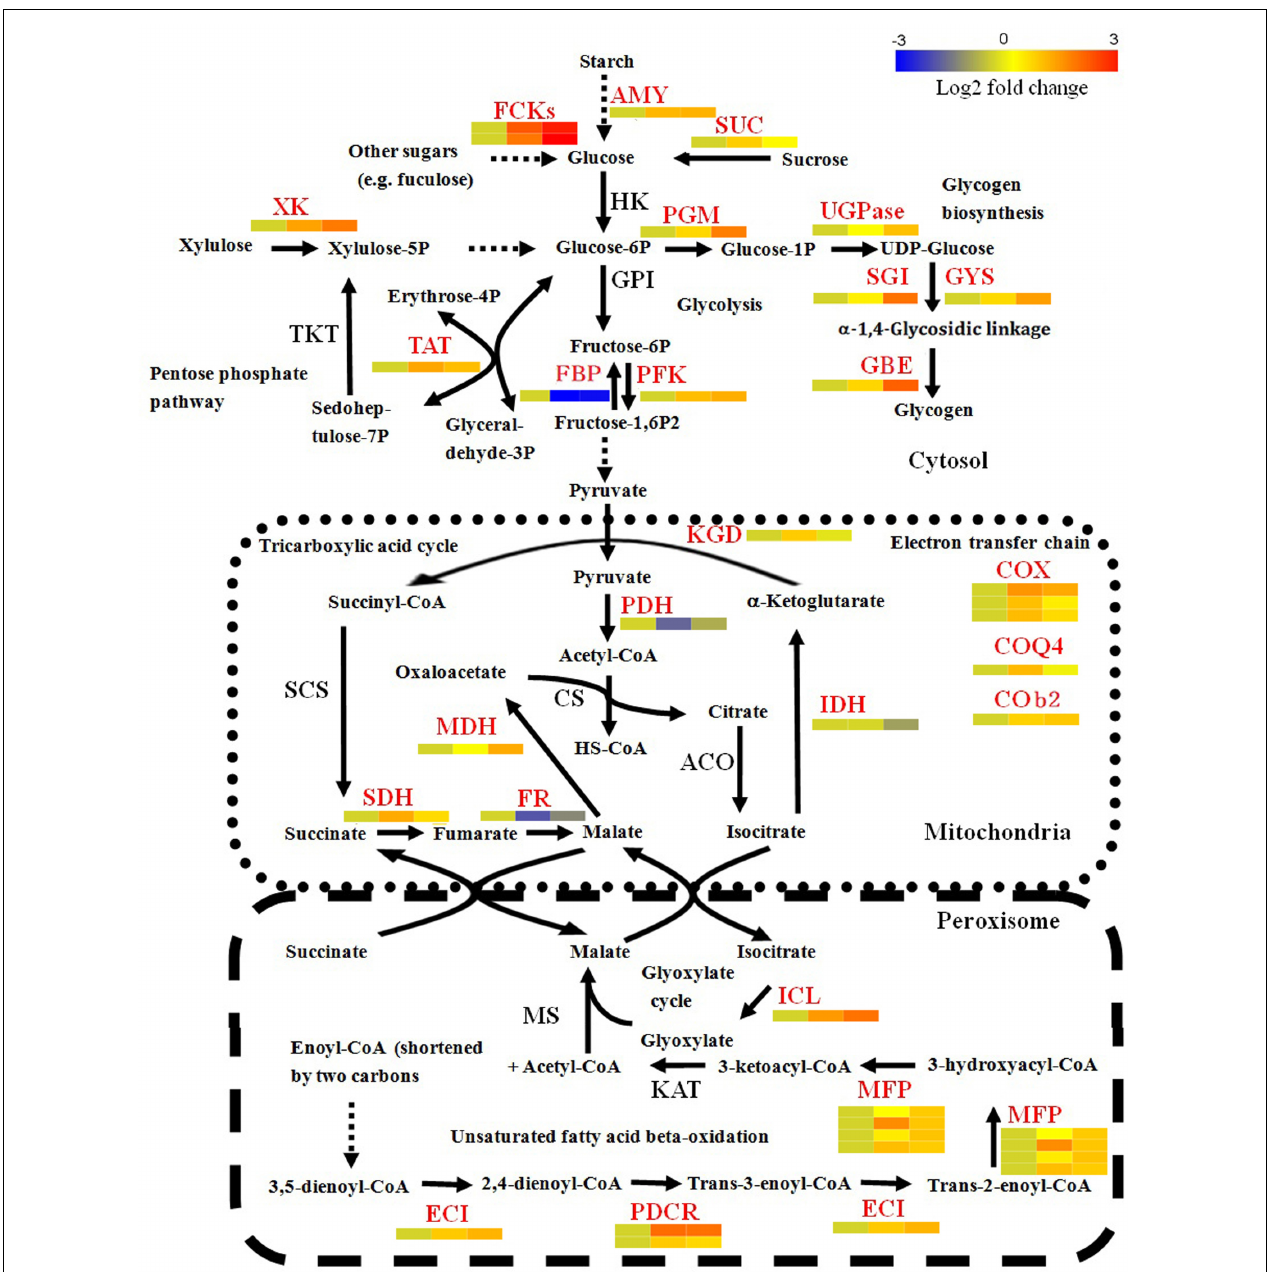
FIGURE 3 | Transcriptional changes of genes involved in basic metabolism in Bgt during asexual development on Chancellor. DEGs are shown in red font. The relative expression levels at 3, 4, and 5 dpi are indicated using heat maps below or aside these genes. Solid and dotted arrows indicate one-step and multiple-step reactions during the catalytic process, respectively. The detail information of these genes is listed in Supplementary Table S3. AMY, α -amylase; FCK, FGGY carbohydrate kinase; SUC, sucrase; HK, hexokinase; GPI, glucose-6-phosphate isomerase; PFK, phospho-fructokinase; FBP, fructose-1,6-bisphosphatase; PGM, phosphoglucomutase; UGPase, UDP-glucose pyrophosphorylase; GYS, glycogen synthase; GBE, glycogen branching enzyme; SGI, self-glucosylating initiator of glycogen synthesis; XK, xylulose kinase; TKT, transketolase; TAT, transaldolase; KGD, α -ketoglutarate dehydrogenase; PDH, pyruvate dehydrogenase complex; IDH, isocitrate dehydrogenase; ACO, aconitase; MDH, malate dehydrogenase; CS, citrate synthase; SDH, succinate dehydrogenase; FR, fumarase; COX, cytochrome c oxidase complex; COQ4, ubiquinone biosynthesis protein COQ4; COb2, cytochrome b2 L -lactate cytochrome-c oxidoreductase; ICL, isocitratelyase; MS, malate synthase; KAT, β -ketoacyl-CoA thiolase; MFP, multifunctional enzyme of the peroxisomal fatty acid beta-oxidation pathway (carrying putative function of enoyl-CoA hydratase, 3-hydroxyacyl-CoA dehydrogenase and 3-hydroxyacyl-CoA epimerase); ECI, enoyl CoA isomerase; PDCR, peroxisomal 2,4-dienoyl-CoA reductase.